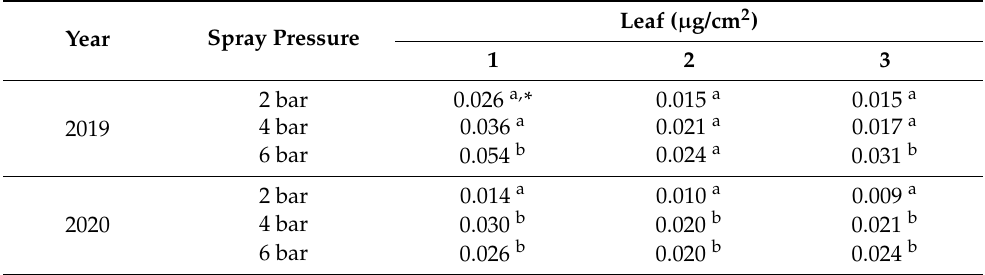
Table 3. Tracer deposit on wheat leaves.